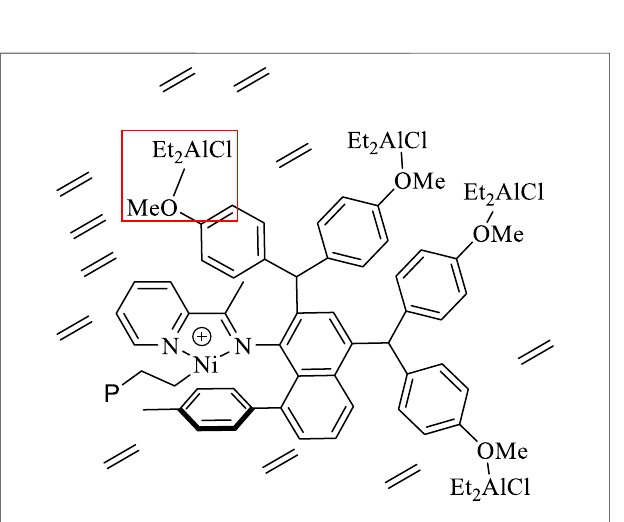
Frontiers in Chemistry |